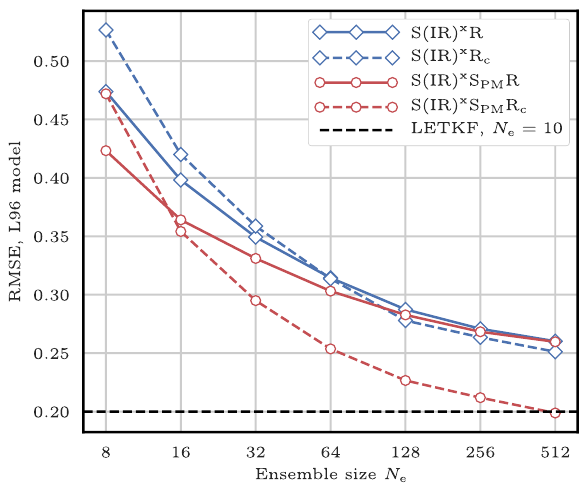
Figure 13. RMSE as a function of the ensemble size N e for S(IR) x R, the S(IR) x R c , the S(IR) x S PM R, and the S(IR) x S PM R al-